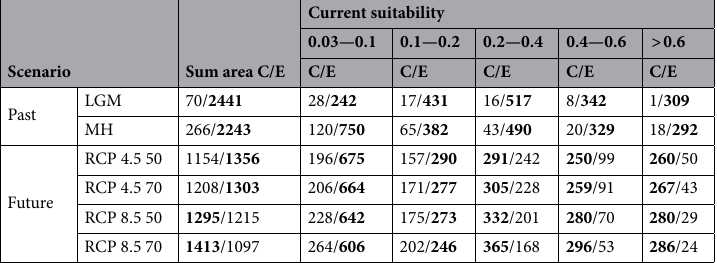
Table 2. Area (10 3 km 2 ) of the regions where suitability is predicted to decrease (C, for contraction) and increase (E, for expansion) for each scenario. For past scenarios C corresponds to suitability past > suitability current and for future scenarios C corresponds to suitability current > suitability future . Each column in the table contains the pair C/E for a class of current suitability and corresponds to a coloured band in Fig. 4, where C is the area on the left hand side of the red line and E is the area on the right hand side. In each cell, the largest value is highlighted in bold.